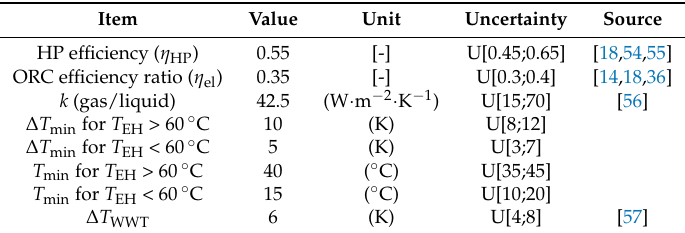
Table 3. Summary of the thermodynamic model parameters and their distribution in the input uncertainty space for the evaluation of the case studies (uniform